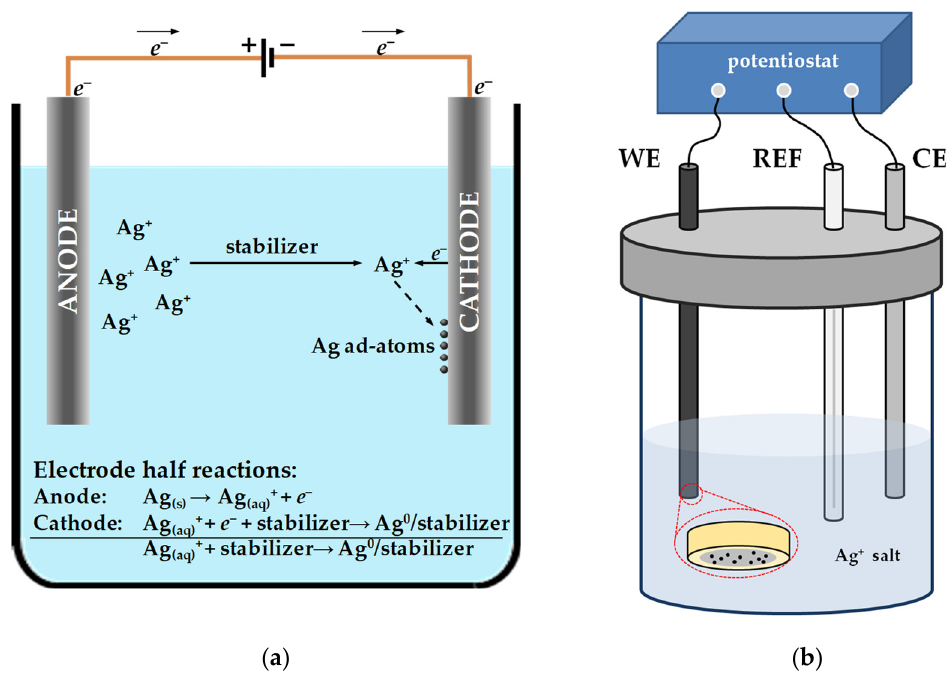
Figure 3. Schematic presentation of an electrochemical synthetic approach in the synthesis of silver nanoparticles using: ( a ) two-electrode electrolytic cell and ( b ) three-electrode electrolytic